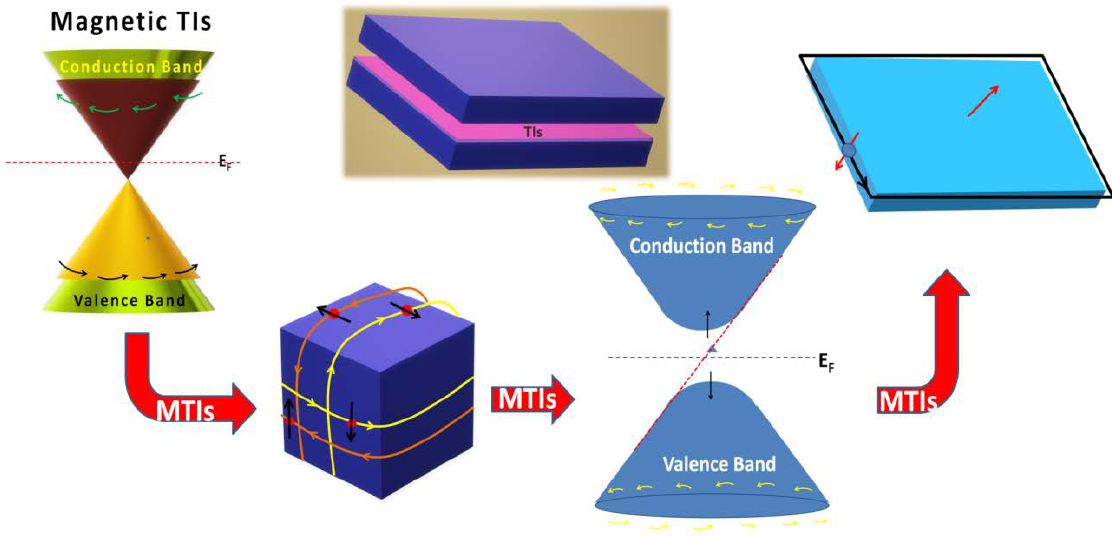
Figure 11. Magnetize visualization characteristics of MTIs.